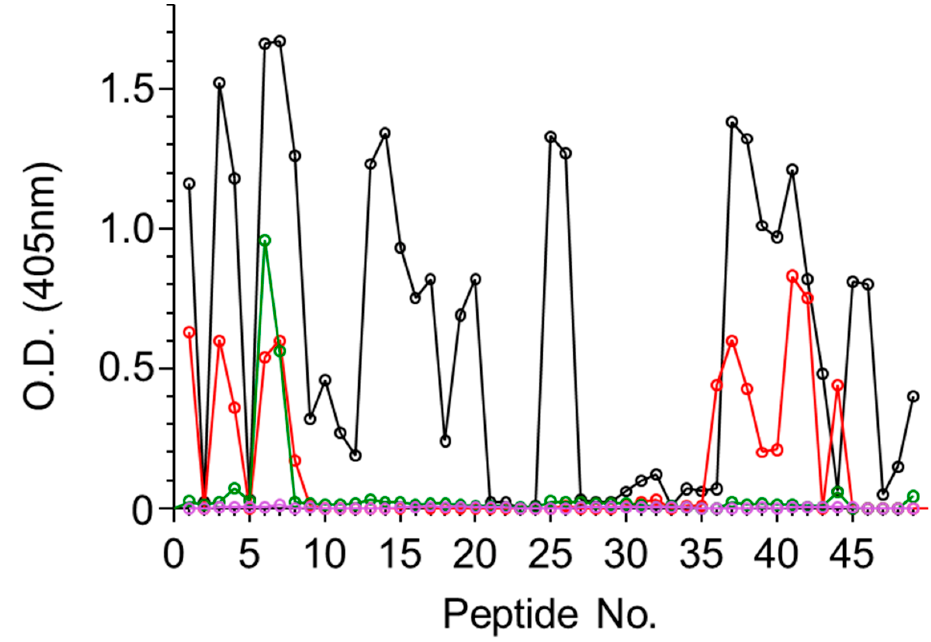
Figure 1. Binding of antiabrin sera to enzymatic A-chain (ATA) peptide array. Set of 15-mer biotinylated peptides spanning amino acid sequence of A subunit of abrin were immobilized on microtiter plates and incubated with antiabrin antibodies R1 (black), R2 (red), R3 (purple), or M1 (green). Plates were then washed, AP-conjugated secondary antibody was added, and antibody binding in each well was determined. Table 2. ATA immunodominant epitopes.